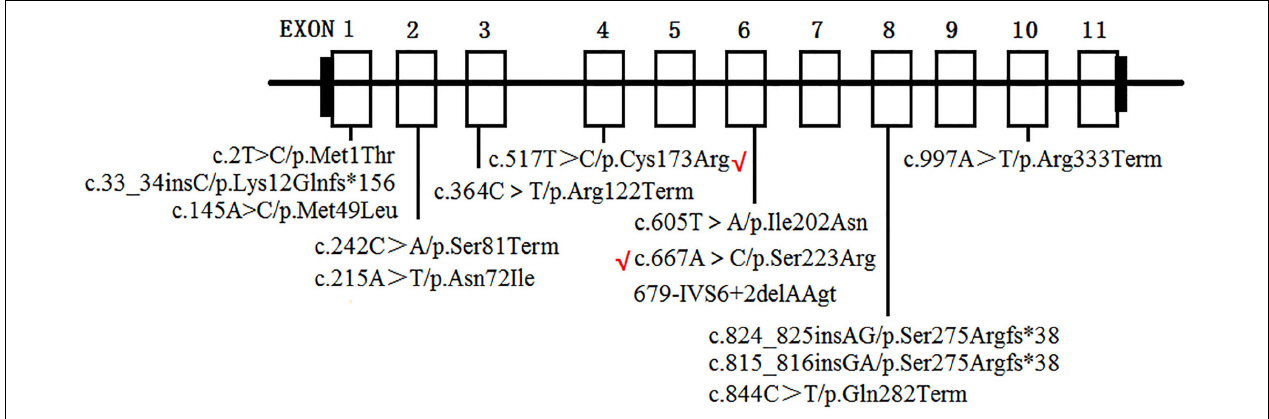
Frontiers in Pharmacology |